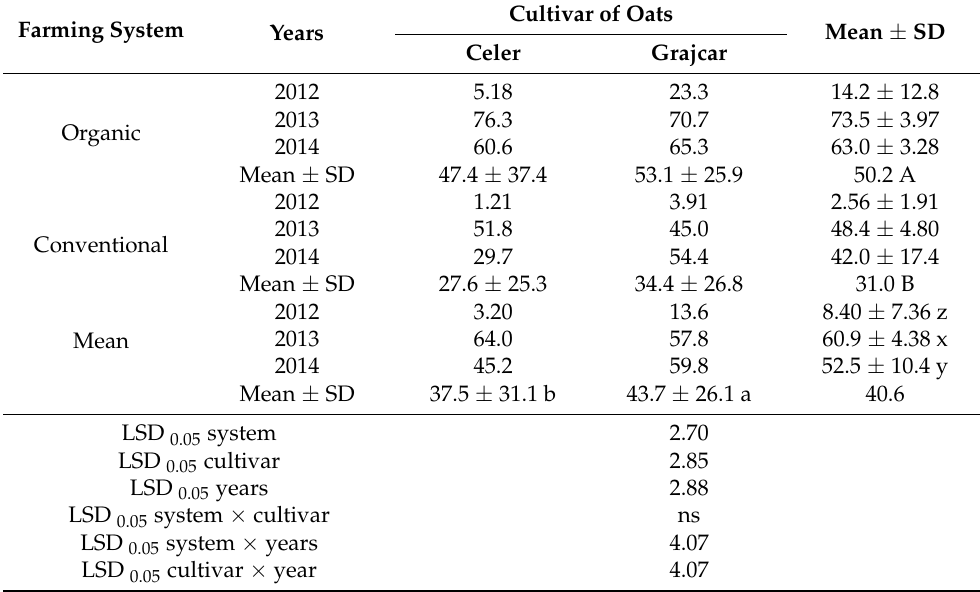
Table 5. The share of vetch seeds (%) in the oat-vetch mixture yields depending on the farming system and oat cultivar in